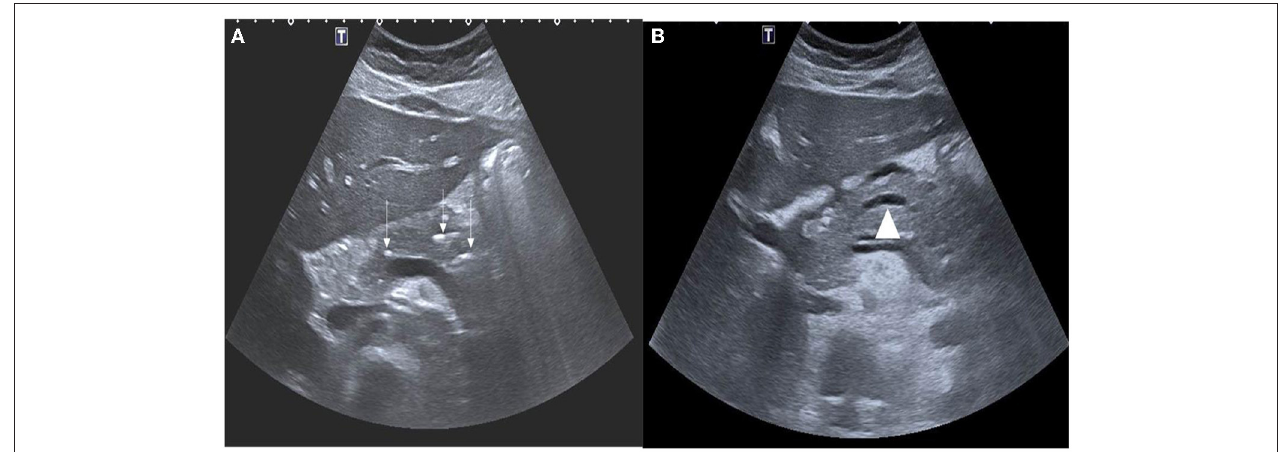
FIGURE 1 | (A) Axial ultrasound images demonstrating multiple foci of calcifications in the pancreas (white arrows). (B) Notice also the dilated main pancreatic duct (arrow head).